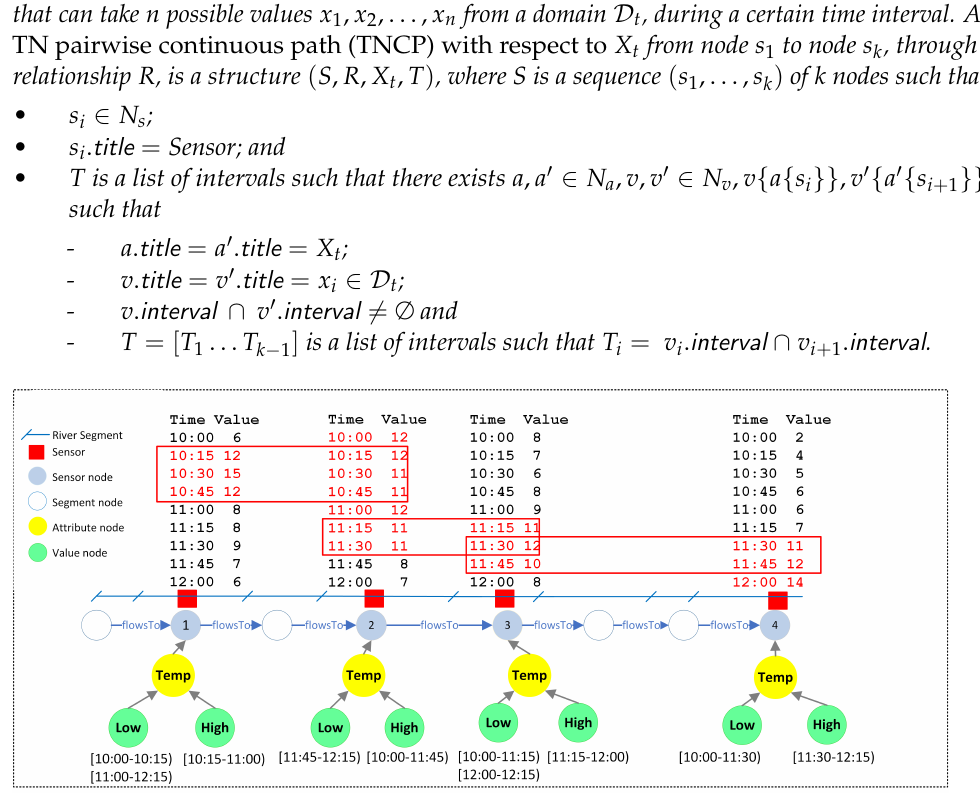
Figure 5. Transportation Network Pairwise Continuous Path of Temperature = High